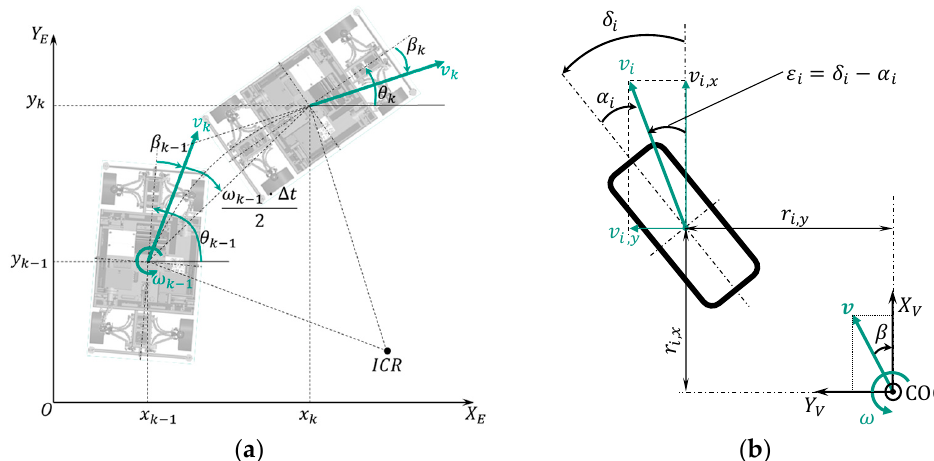
Figure 5. ( a ) Movement of a vehicle from time step 𝑘 − 1 to 𝑘 ; ( b ) kinematic relationship between wheel velocity and vehicle velocity.